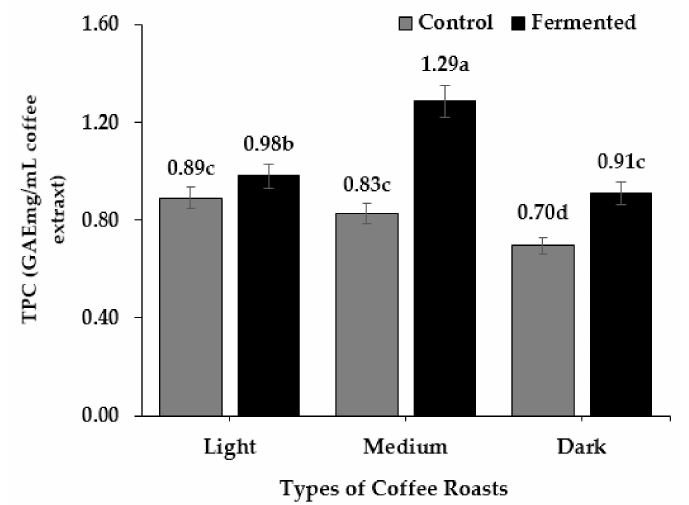
Figure 6. Total phenol contents (GAE mg / mL of co ff ee extract) of fermented co ff ee. Bars with di ff erent letters indicate a significant di ff erence ( p < 0.5) among